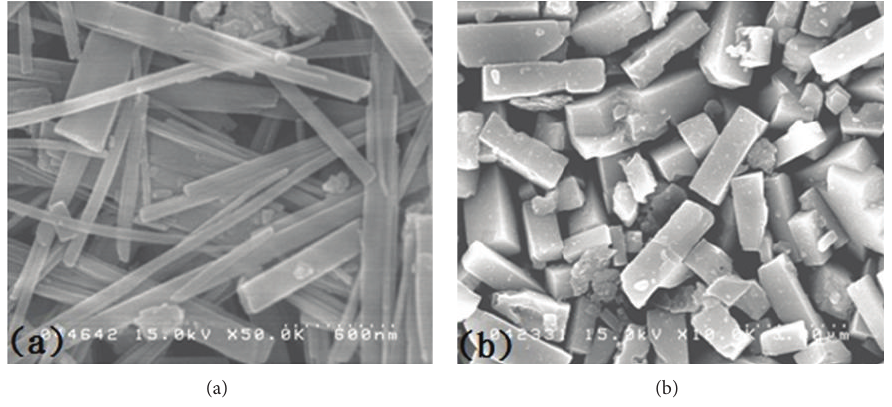
Figure 5: Nanorod size dependence on the using of the particle size of (a) 14nm and (b) 100nm.